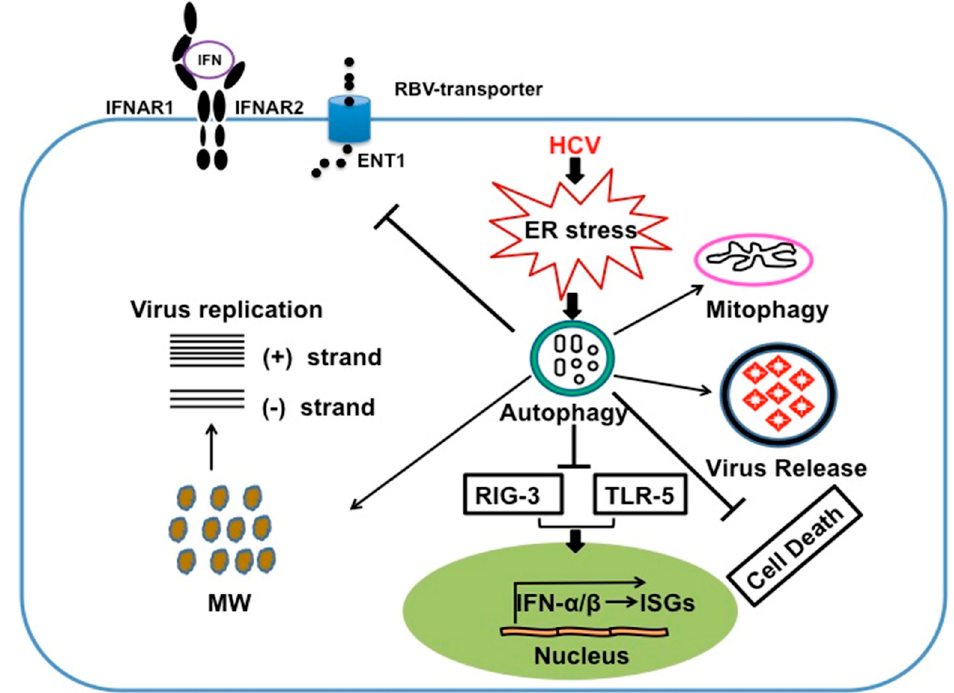
Figure 7. Diagram illustrating how autophagy response adapts to HCV induced cellular stress response leading to chronic infection. HCV replication induces ER-stress/UPR response that triggers autophagy that favors cell survival through inhibition of apoptosis and mitophagy. HCV induced autophagy response inhibits interferon production and interferon inducible genes (ISG) transcription and impairs Janus kinase/signal transducers and activators of transcription (JAK/STAT)signaling by degradation of IFN- α receptor 1 (IFNAR1) and RBV transporter. Autophagy response created autophagosome that support HCV replication and release.